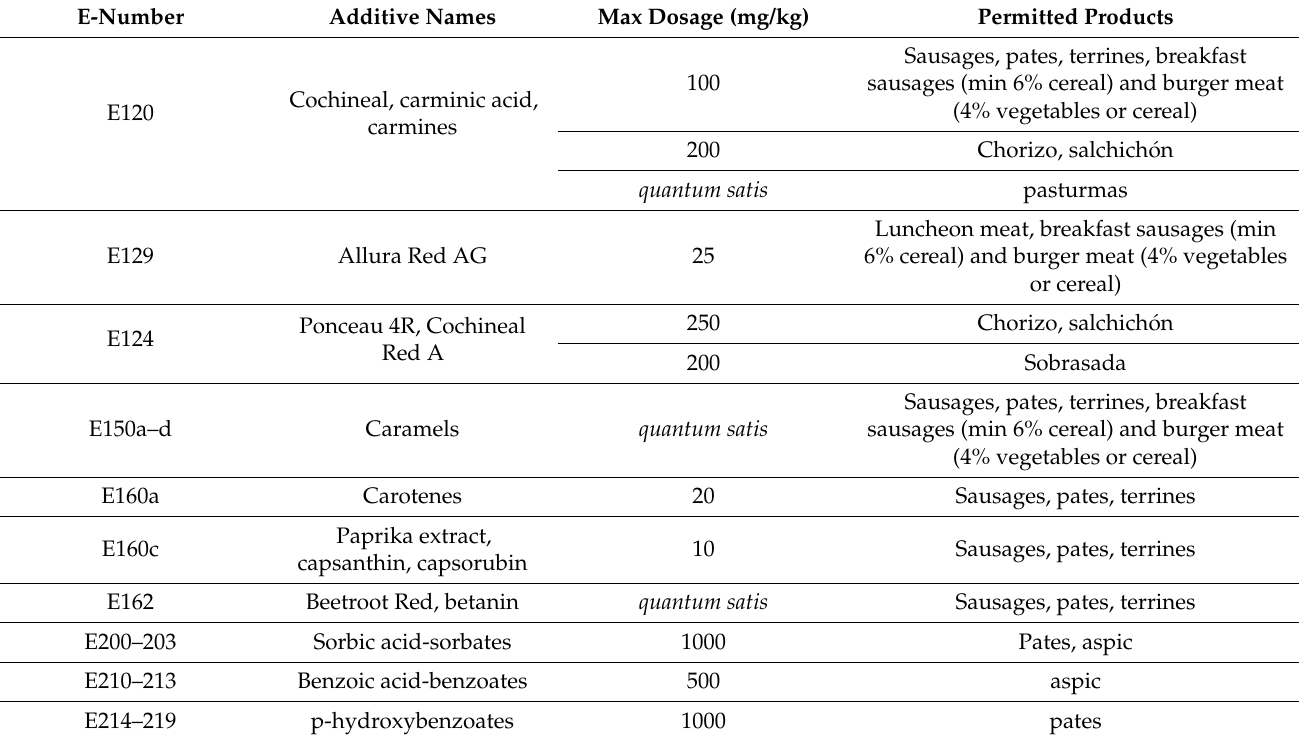
Table 1. Additives permitted in the EU for meat product according to Reference